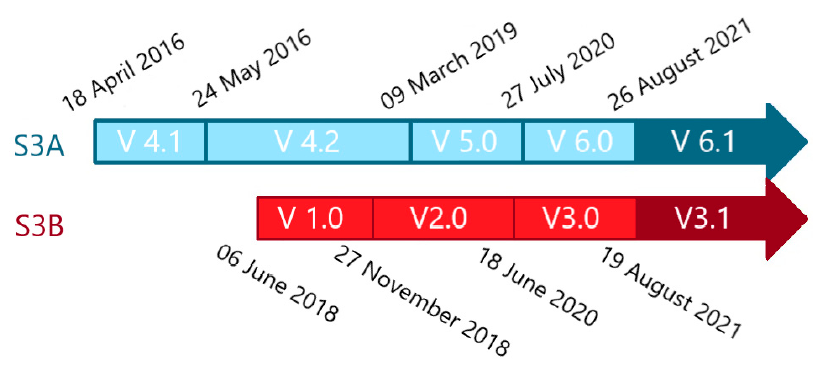
Figure 2. OLTC versions of Sentinel ‐ 3A (S3A) and Sentinel ‐ 3B (S3B) over time. The version number is indicated by the number in the arrow, while the time of the version change is provided at the top or bottom of the arrow (courtesy of https://www.altimetry ‐ hydro.eu/, accessed on 6 August 2022).